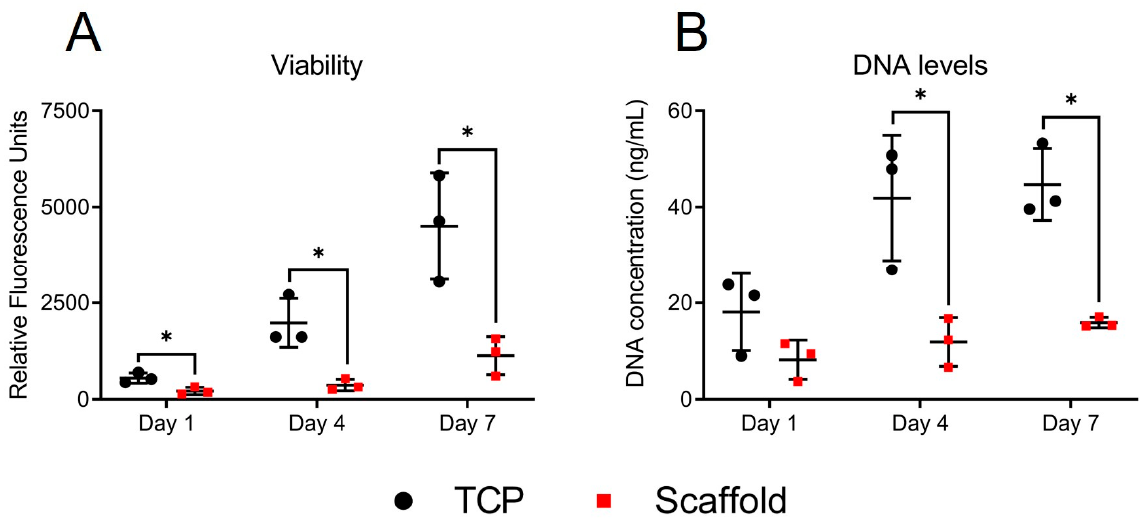
Figure 3. PrestoBlue™ and PicoGreen™ assay data using NOF. ( A ) PrestoBlue viability data ( B ) PicoGreen data. Fluorescence and absorbance were read using a Tecan M200 plate reader and Magellan analysis software. GraphPad Prism software was used to generate graphs. * p < 0.05. Error bars represent standard deviation, (biological replicates = 3, technical replicates = 3).